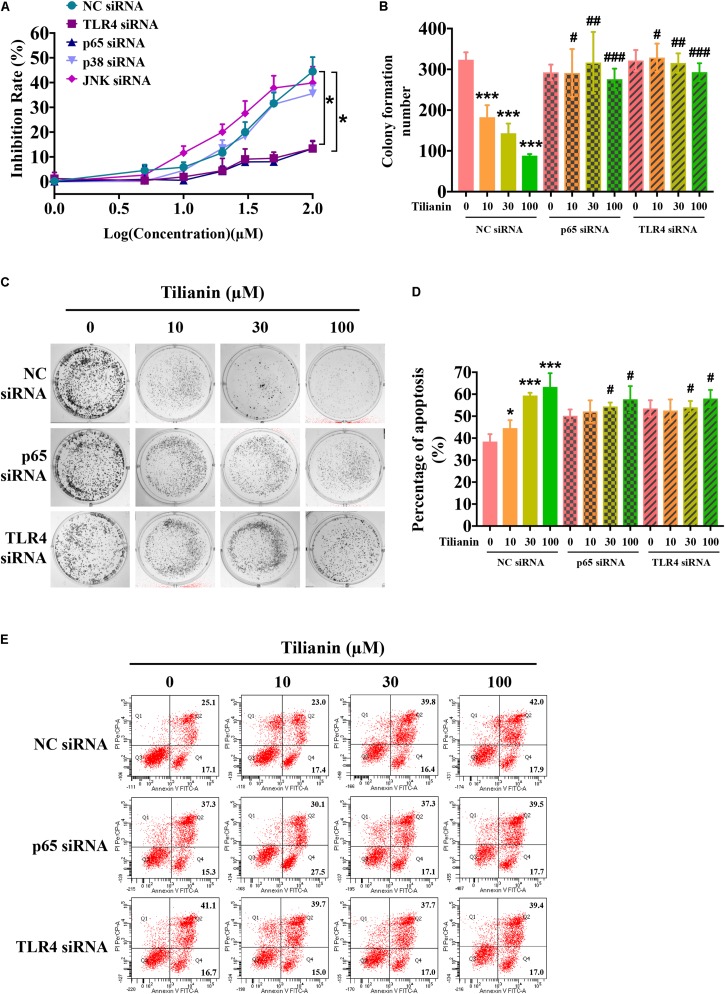
TLR4 and p65 contribute to the cytotoxic effects of tilianin on FaDu cells. (A) Tilianin treatment does not decrease cell viability of FaDu cells after silencing of TLR4 and p65 by siRNA. (B) Colony numbers calculated by image J. software. (C) Tilianin treatment does not inhibit cell colony formation in the presence of TLR4 siRNA and p65 siRNA. (D) The percentage of apoptosis analyzed by BD FACSCanto II. (E) Tilianin treatment does not induce cell apoptosis after treatment of FaDu cells with TLR4 siRNA and p65 siRNA. Results are expressed as the mean ± SD, n = 6. * P < 0.05, *** P < 0.001 vs. control. #P < 0.05, ##P < 0.01, ###P < 0.001 vs. tilianin.